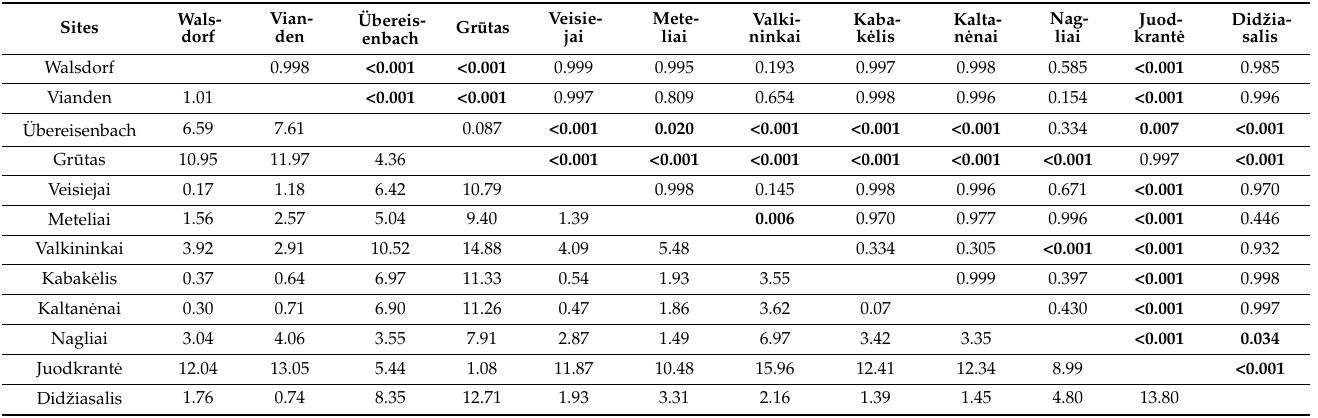
Table A3. Results of pairwise comparisons of the number of matured seeds between sites using Tukey’s post-hoc test.